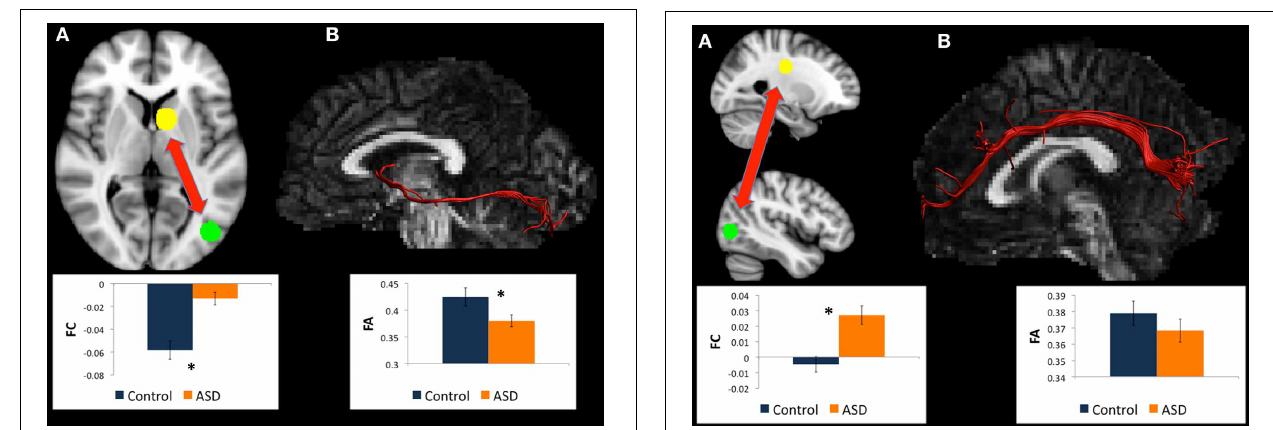
FIGURE 1 | (A) Regions for tractography in left BA19 (green sphere) and left caudate head (yellow sphere). The ASD group showed weaker functional connectivity relative to controls between these regions during a mental rotation task. The bar graph shows the strength of functional connectivity (FC) in the Control group (blue) and ASD group (orange) between these seed regions. (B) Example of white matter tracts that directly connect the left BA19 and left caudate head regions in one participant. The bar graph shows Fractional Anisotropy (FA) in the Control group (blue) and ASD group (orange) in these white matter tracts. ∗ indicates statistical significance with p < 0 . 05.